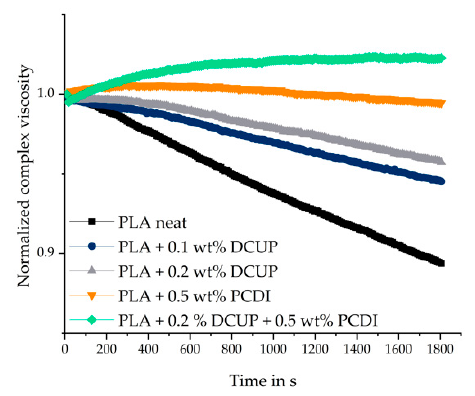
Figure 4. Normalized time-dependent viscosity of the compounds.